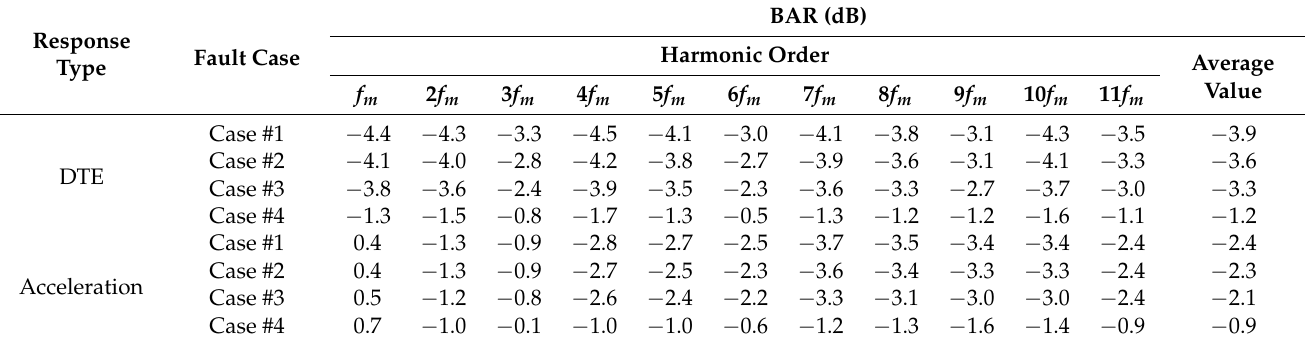
Table 3. Sideband amplitude ratio (BAR) values of different fault